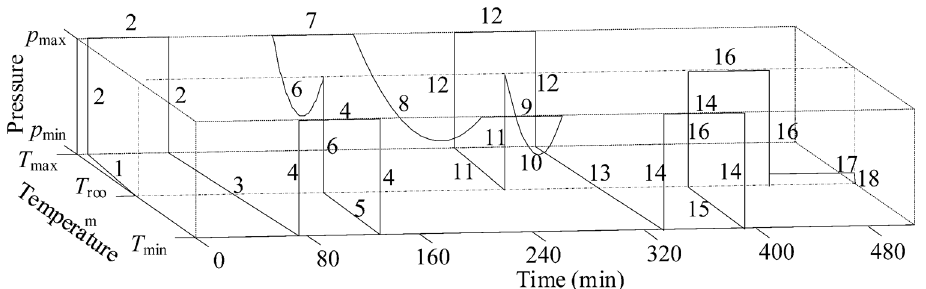
Figure 12. Flow chart of temperature cycle test loading.